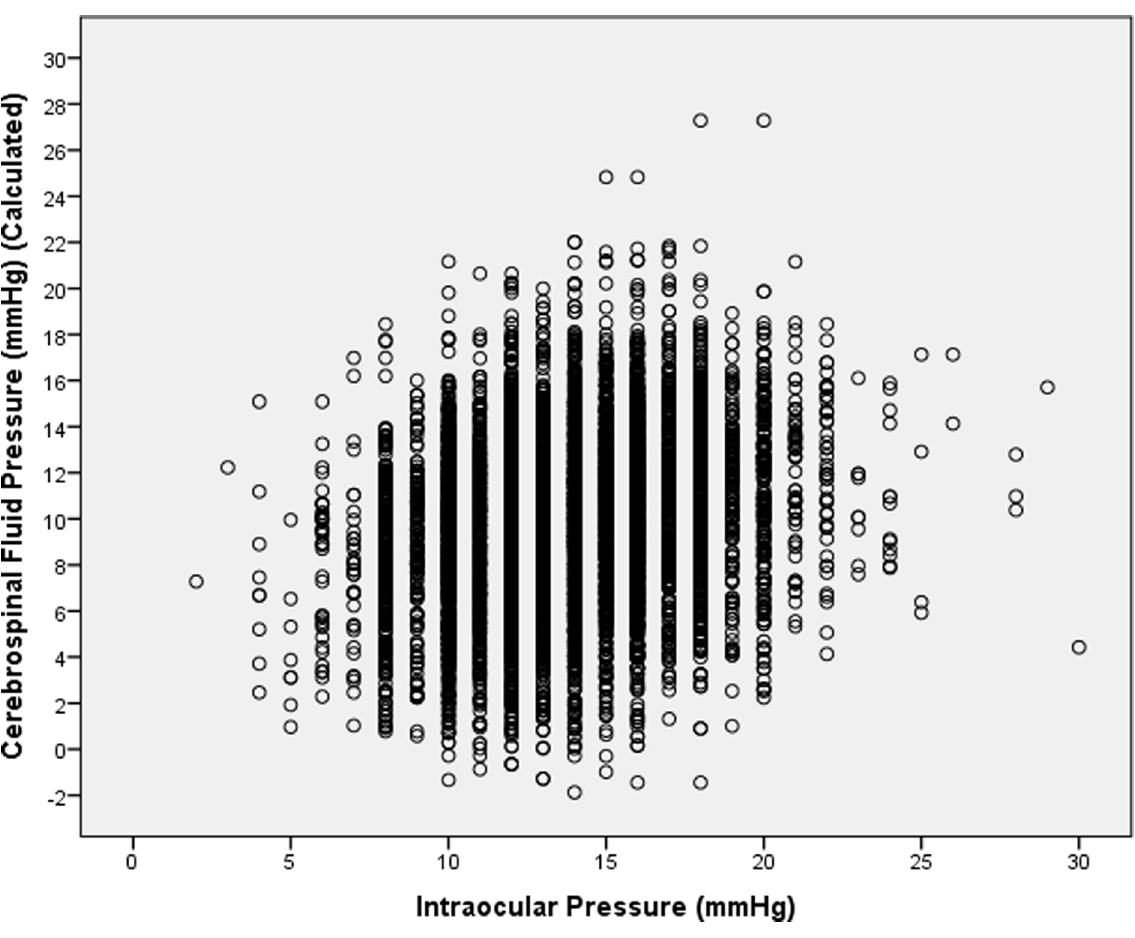
Figure 3. Scattergram showing the correlation between measured intraocular pressure and calculated cerebrospinal fluid pressure in the non-glaucomatous and non-highly myopic population of the Central India Eye and Medical Study. (P , 0.001; correlation coefficient r: 0.22; equation of the regression line: Calculated Cerebrospinal Fluid Pressure [mmHg]=0.25 6 Intraocular Pressure [mmHg] + 6.64 mmHg).